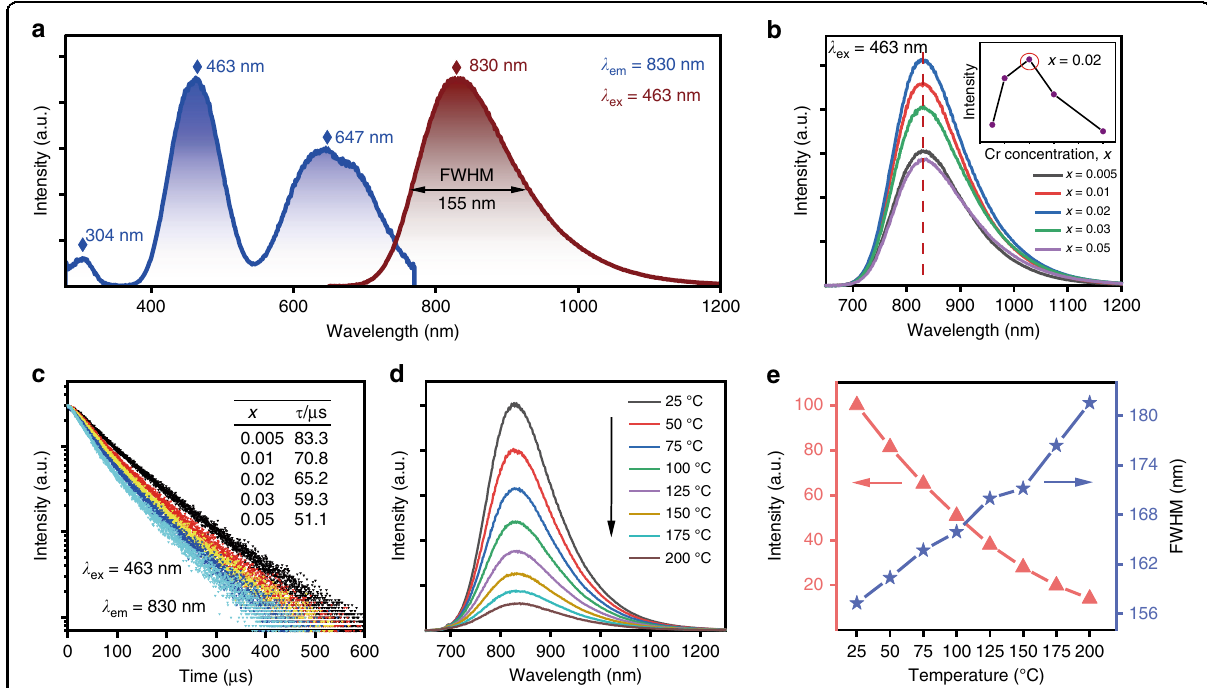
Fig. 2 Luminescence properties of Lu 0.2 Sc 0.8 BO 3 :Cr 3 + phosphors. a Normalized excitation and emission spectra of Lu 0.2 Sc 0.8 BO 3 :Cr 3 + . b Dependence of emission spectra of Lu intensity at varied Cr 3 + -doping concentration. c Luminescence decay curves of Lu 0.2 Sc 0.8 BO 3 : x Cr 3 + phosphors. d Emission spectra of Lu 0.2 Sc 0.8 BO 3 :2% Cr 3 + phosphor at different temperature from 25 to 200 °C. e NIR emission intensity and FWHM of Lu 0.2 Sc 0.8 BO 3 :2%Cr 3 + phosphor at